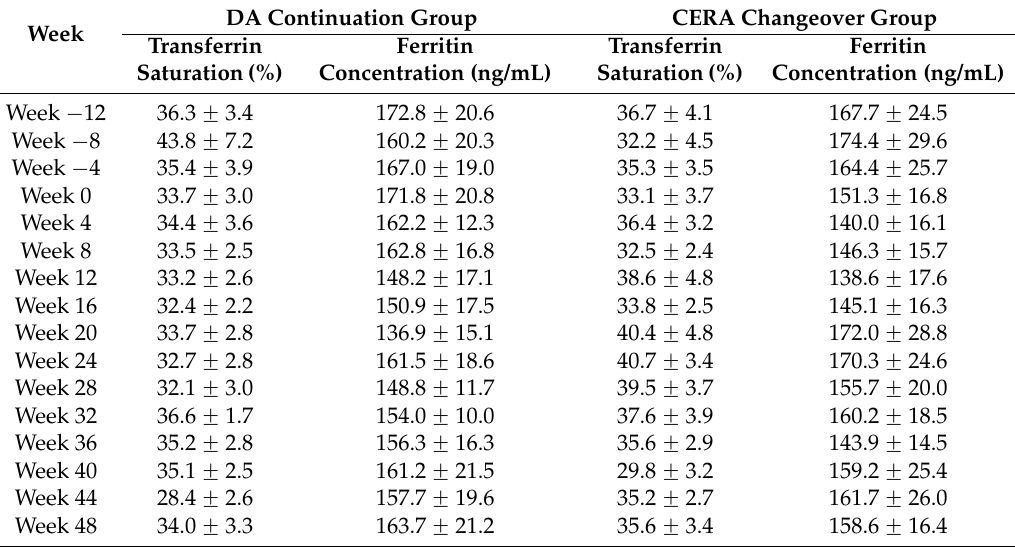
Table 3. Change in iron status during the fixed dose period and the evaluation